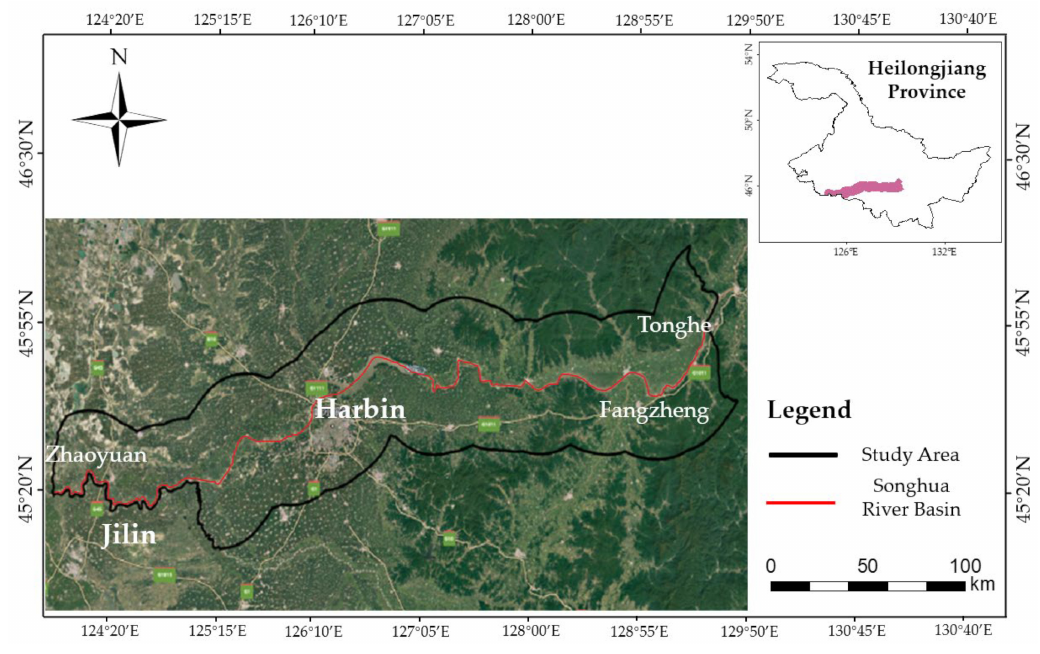
Figure 1. The overview of the research